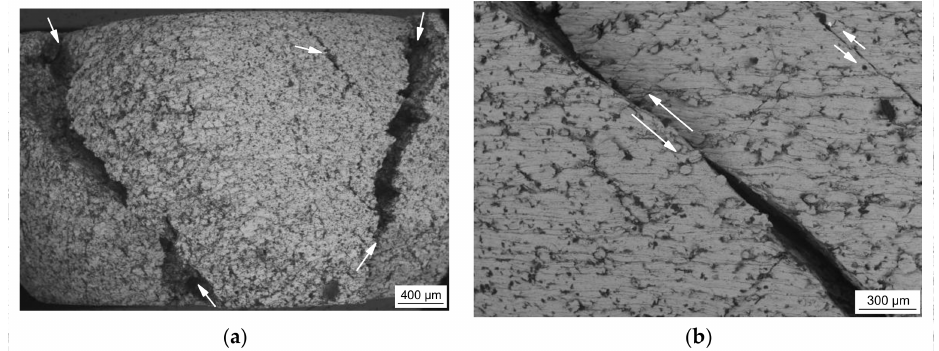
Figure 9. Damage of two selected TRIP-steel syntactic foams at 60% strain under dynamic impact loading: ( a ) with 60 vol % S60HS glass microspheres (T6G); ( b ) with 20 vol % Fillite 106 cenospheres (T2C); the arrows mark the damage sites. (Load direction is vertical).